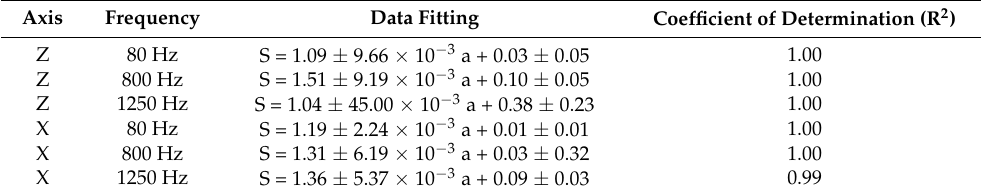
large knit-braided outer sheath. S is the sensor response, a is the amplitude.